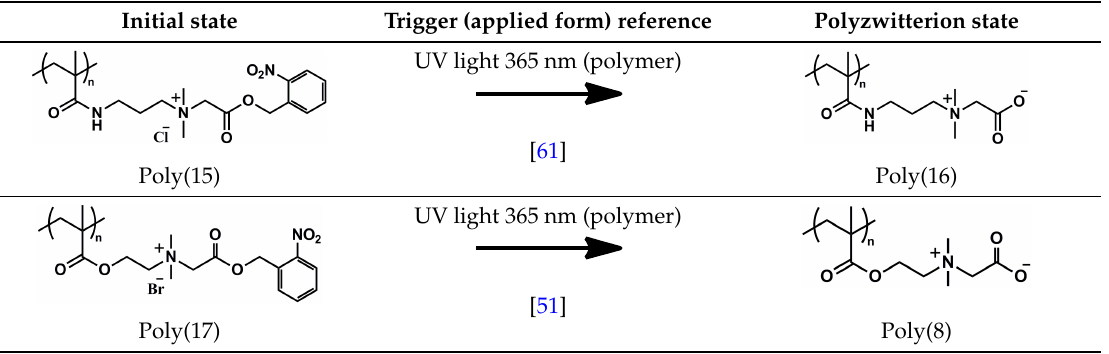
Table 1. Irreversible pH-triggered (meth)acrylic-based switches containing polyzwitterionic state. Table 3. Irreversible light-triggered (meth)acrylic-based switches containing polyzwitterionic state.